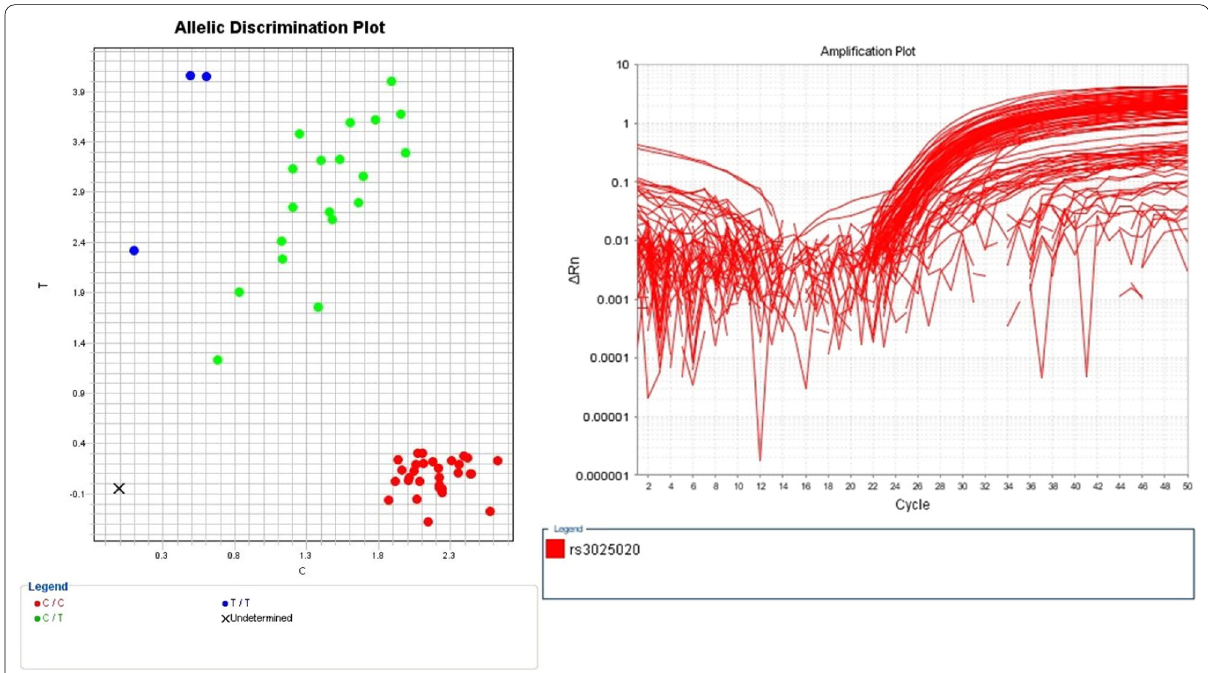
Fig. 1 Allelic discrimination and amplification plots of